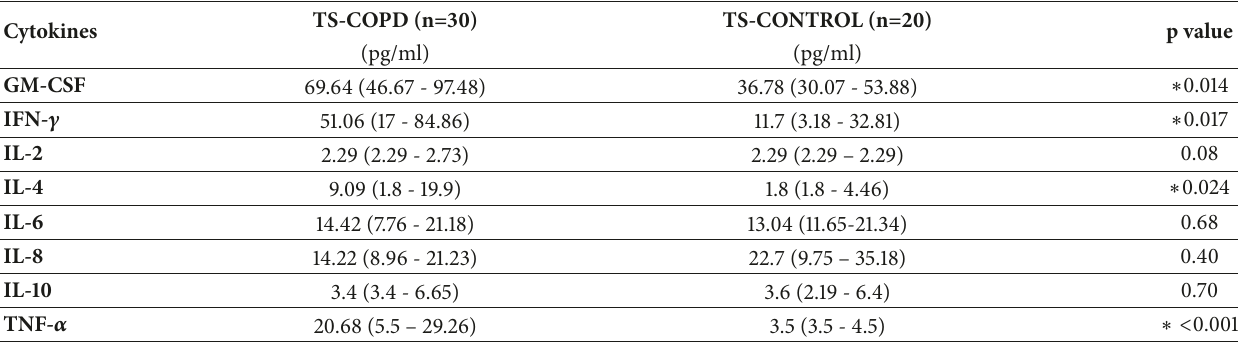
Table 2: Serum concentrations [median (25th–75th percentile) pg/ml] of the eight cytokines measured in tobacco smokers with chronic obstructive pulmonary disease (TS-COPD) and TS CONTROL subjects. ∗ p < 0.05 is considered as